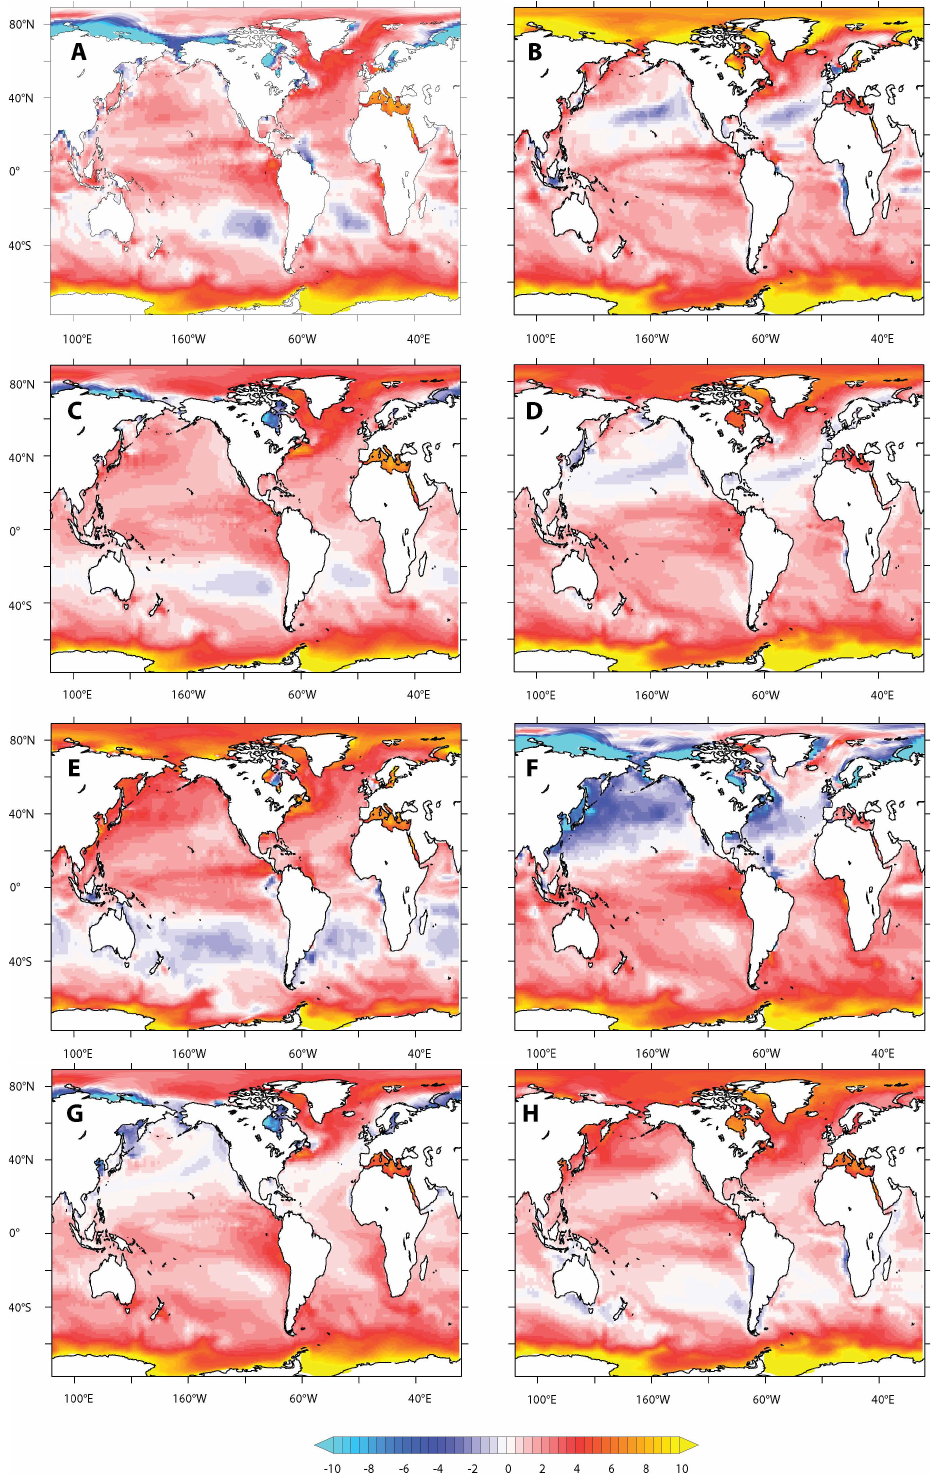
Fig. 2. (A) and (B) Decadal trends (µatm decade − 1 ) in February (August) 1p CO 2 over 1970–2000 computed from the annual mean of Alkalinity and the seasonal DIC, SST and Salinity; (C) and (D) same as (A) and (B) but using the annual mean of Salinity and the seasonal Alkalinity, DIC and SST in the 1p CO 2 calculation; (E) and (F) , same as (A) and (B) but using the annual mean of DIC and the seasonal Alkalinity, SST, and Salinity; (G) and (H) same as (A) and (B) but using the annual mean of SST and the seasonal DIC, Salinity, and